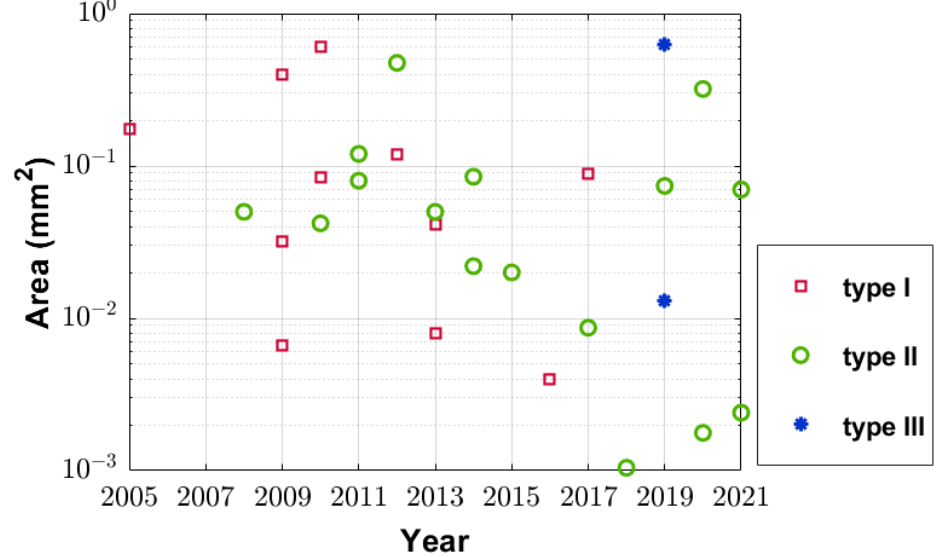
Figure 9. Area (log scale) versus the year of publications for all three types of MOS-based tempera- ture sensors.